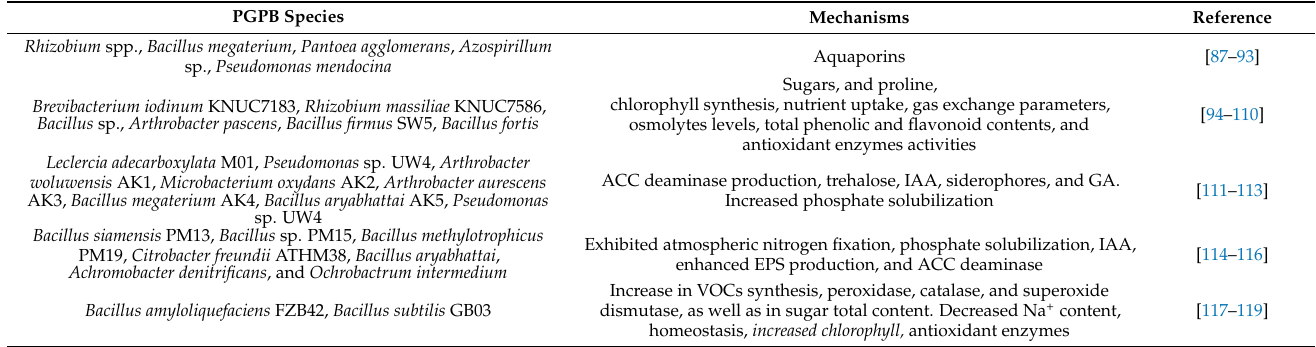
Table 1. Plant growth-promoting bacteria (PGPB) and their mechanisms targeted at helping plants to deal with salinity